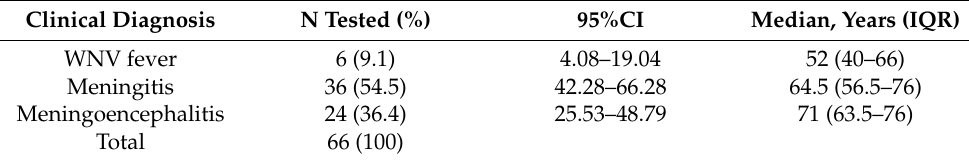
Table 2. Clinical diagnosis of patients with WNV